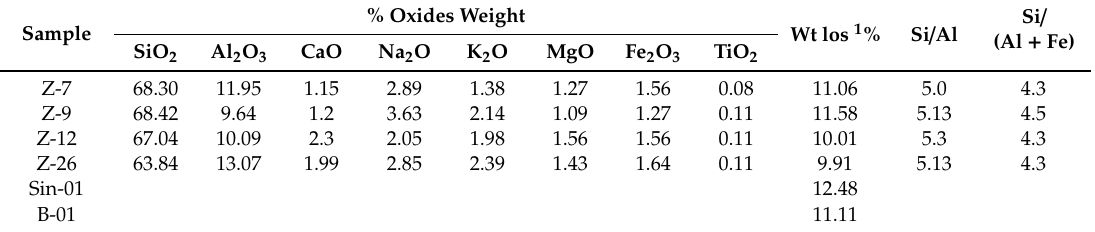
Table 2. Chemical composition of the natural mordenite samples obtained from X-ray fluorescence.